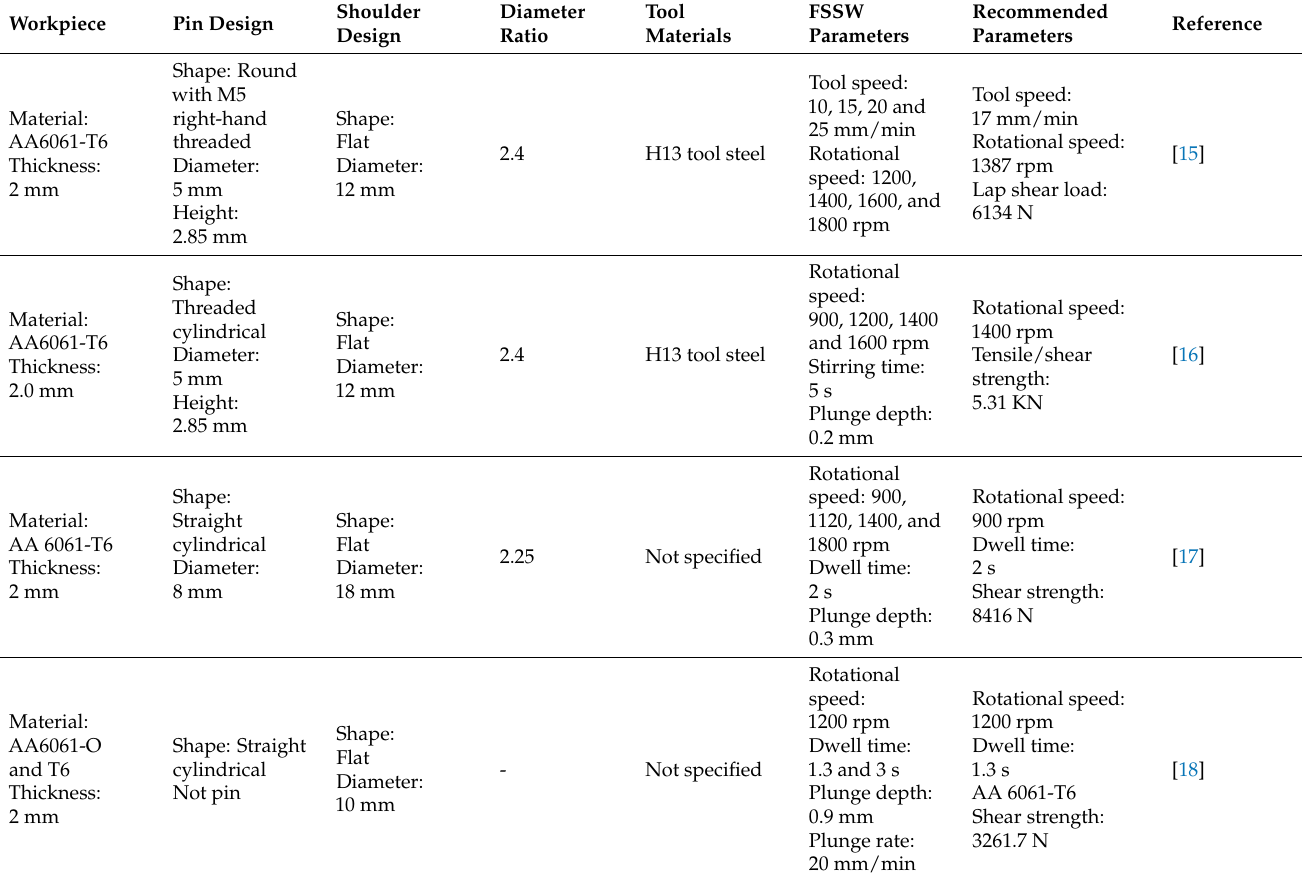
Table 1. Highlights of previous research on the FSSW of 6061 aluminum